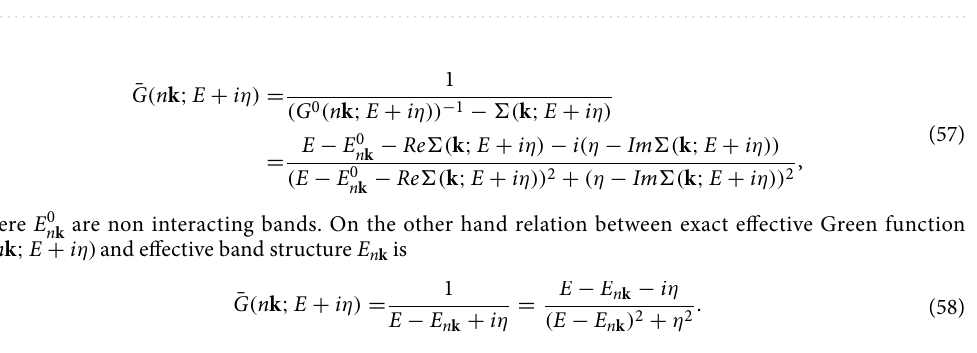
Figure 3. Shows real states eigen values of calculated density of states are maximums of N ( k are fake that should be